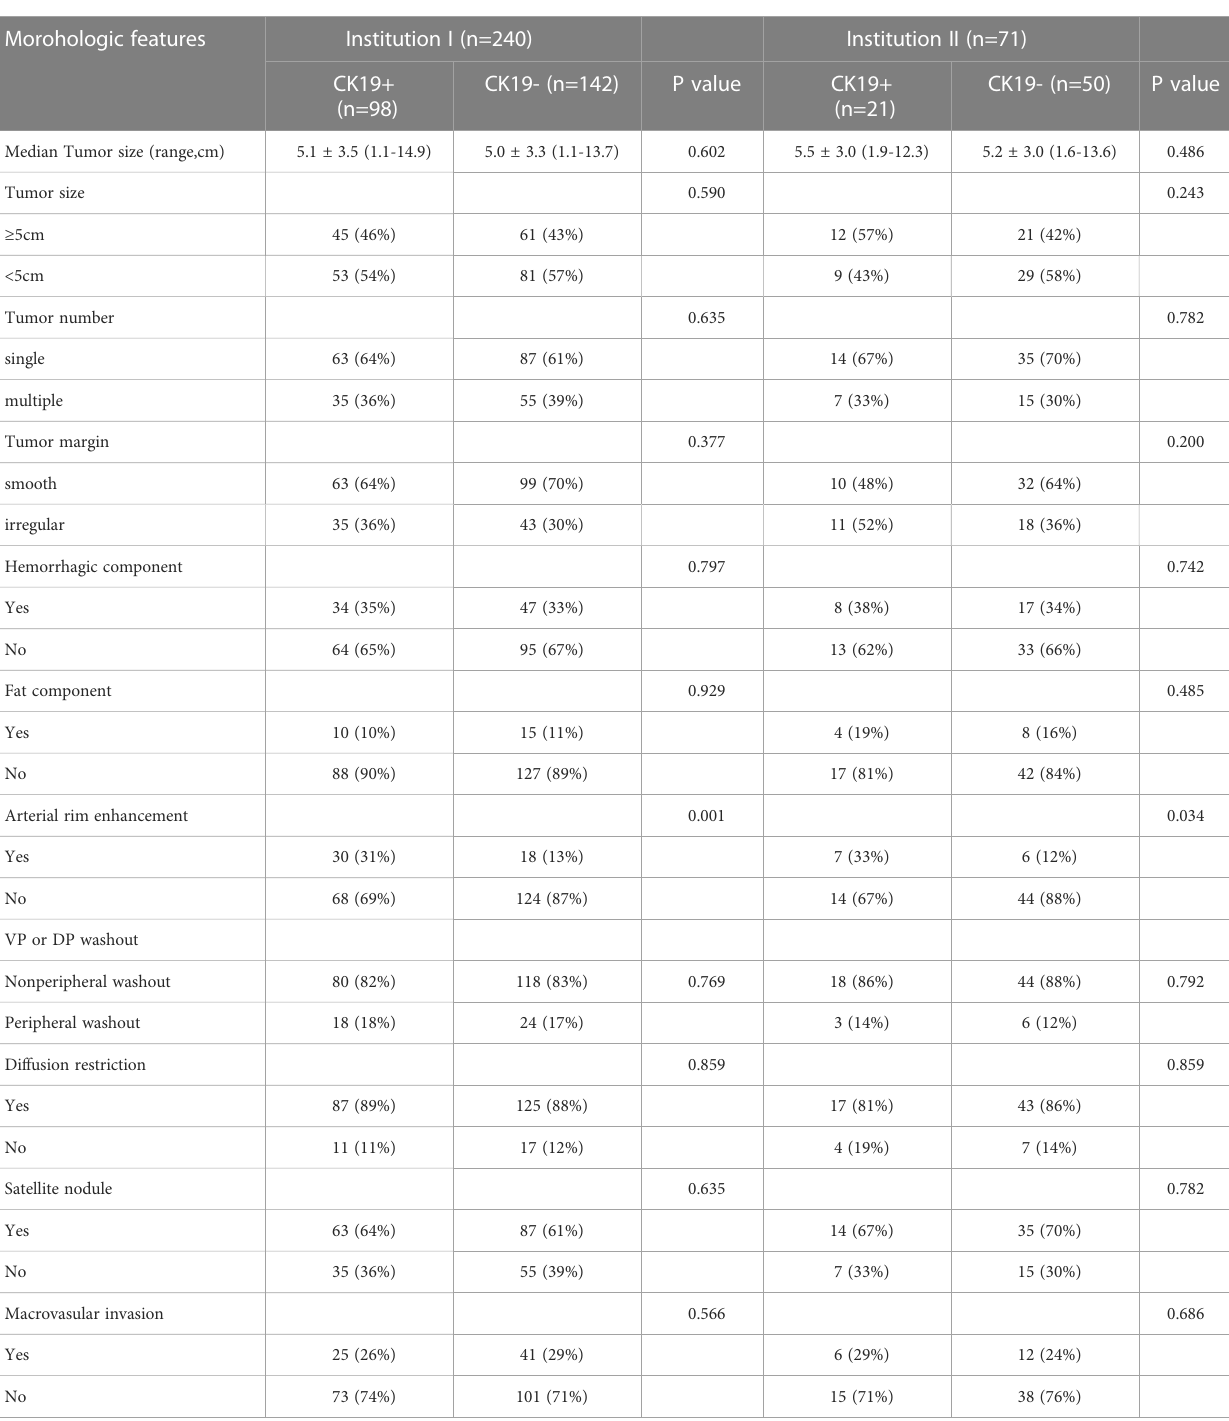
TABLE 3 MRI semantic features of institution I and institution II. Morohologic